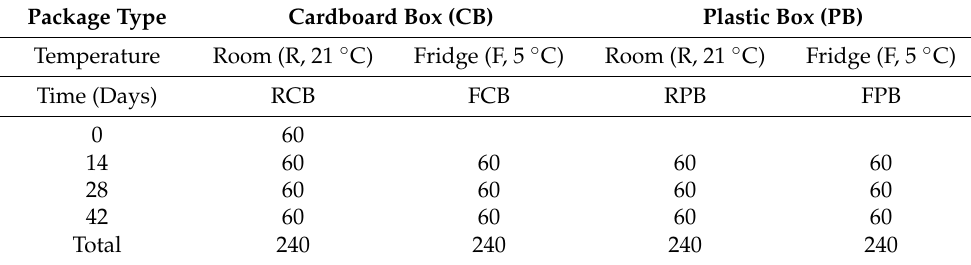
Table 1. Schema of the